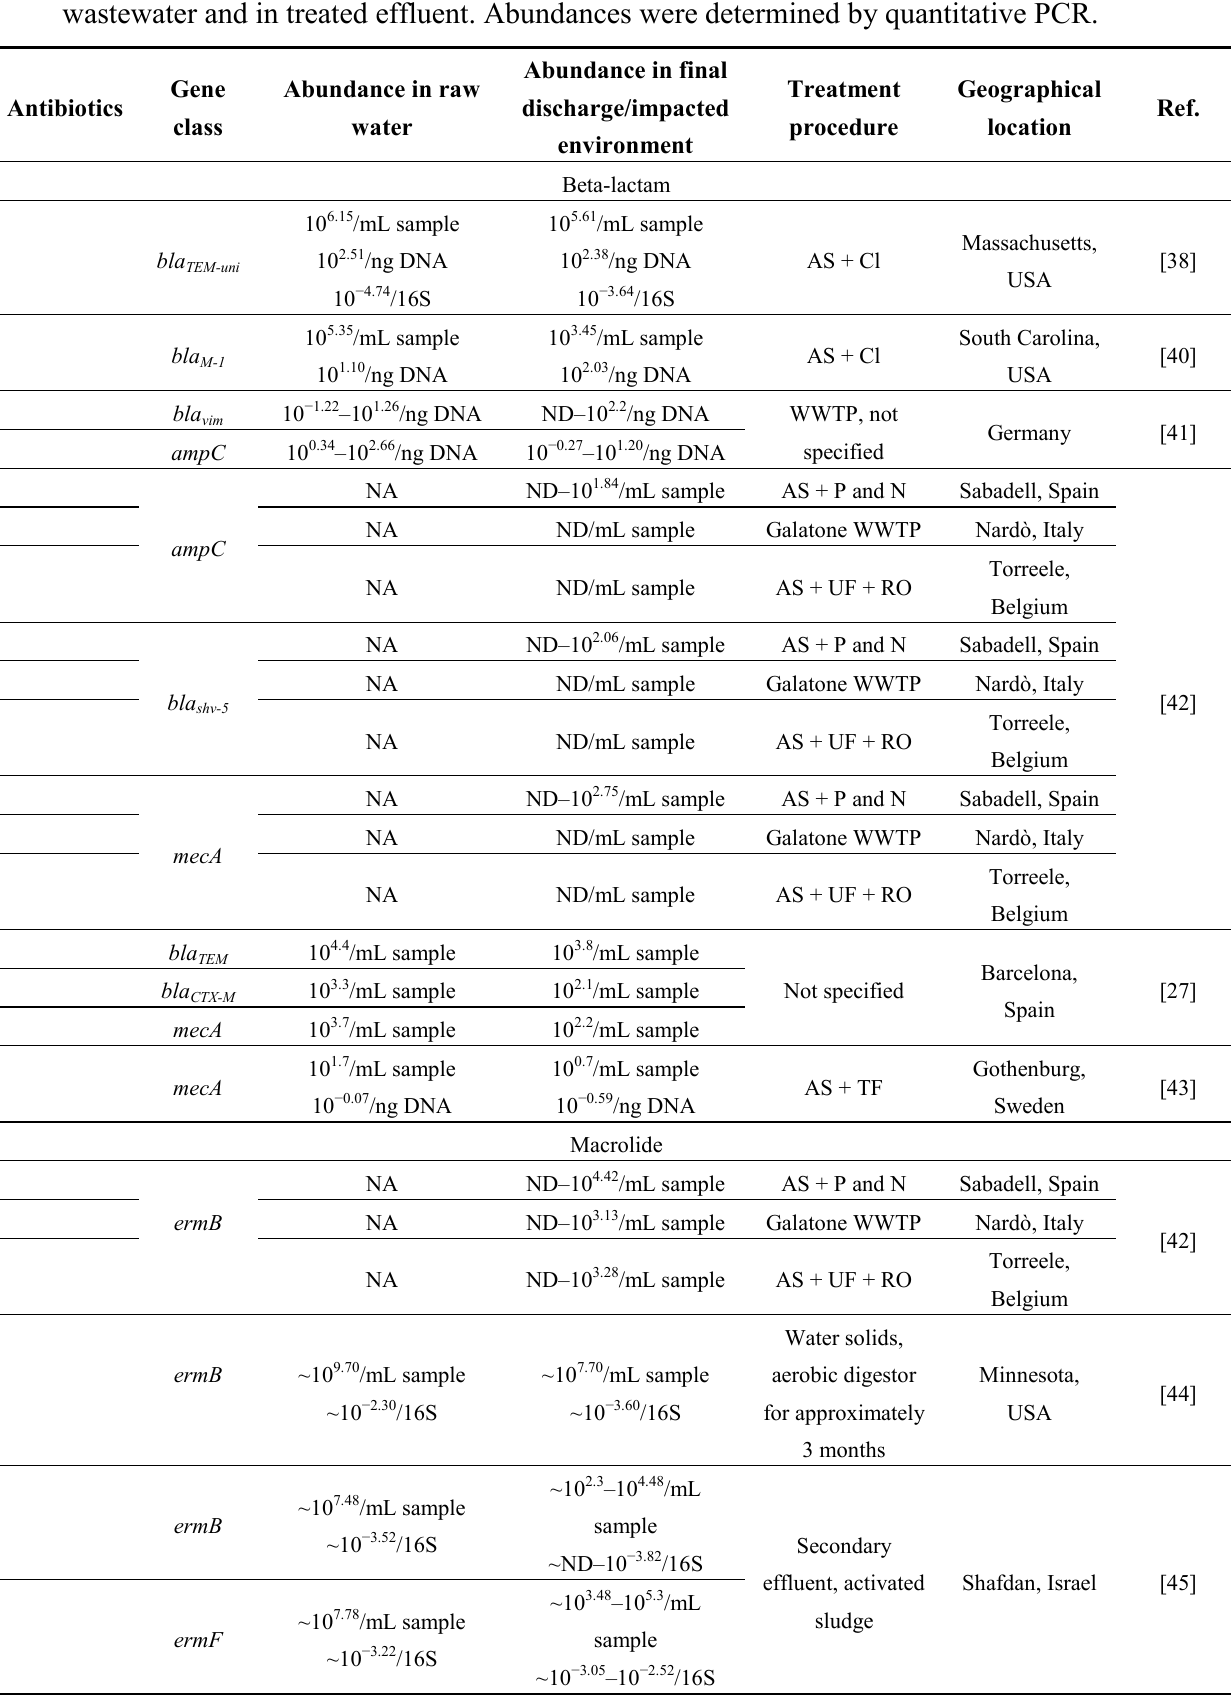
Table 1. Abundance of antibiotic resistance genes that was present in untreated municipal wastewater and in treated effluent. Abundances were determined by quantitative